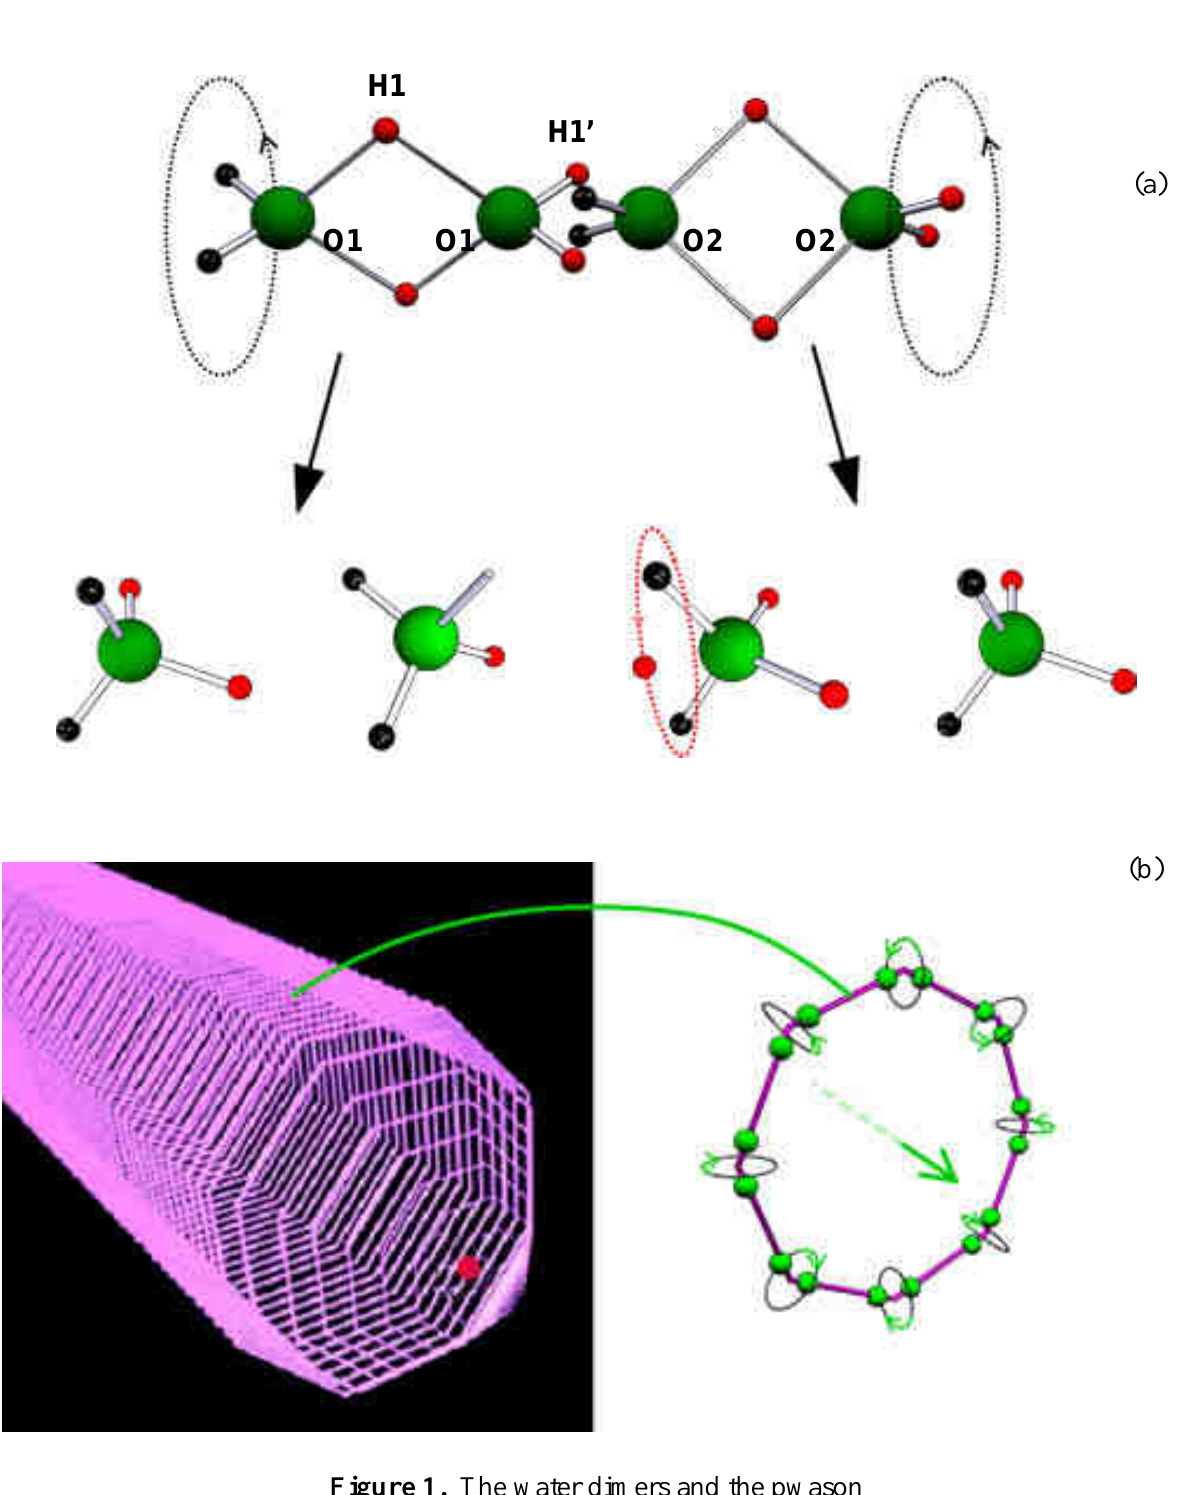
Figure 1. The water dimers and the